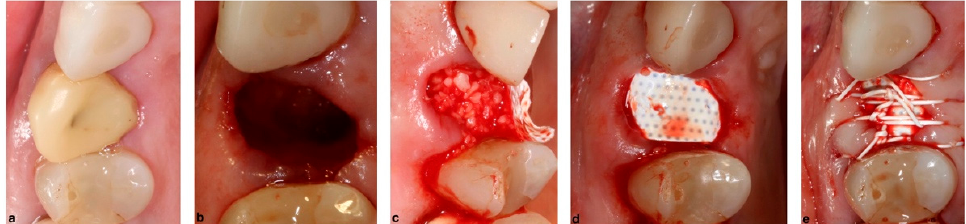
Figure 4. Alveolar ridge preservation with allogenic bone graft and a non-resorbable dPTFE mem- brane: ( a ) maxillary right canine prior to extraction, ( b ) canine extraction site, ( c ) freeze-dried bone allograft placed in the socket, ( d ) dPTFE non-resorbable membrane placed over bone graft, and ( e ) sutures placed to secure membrane and bone graft.